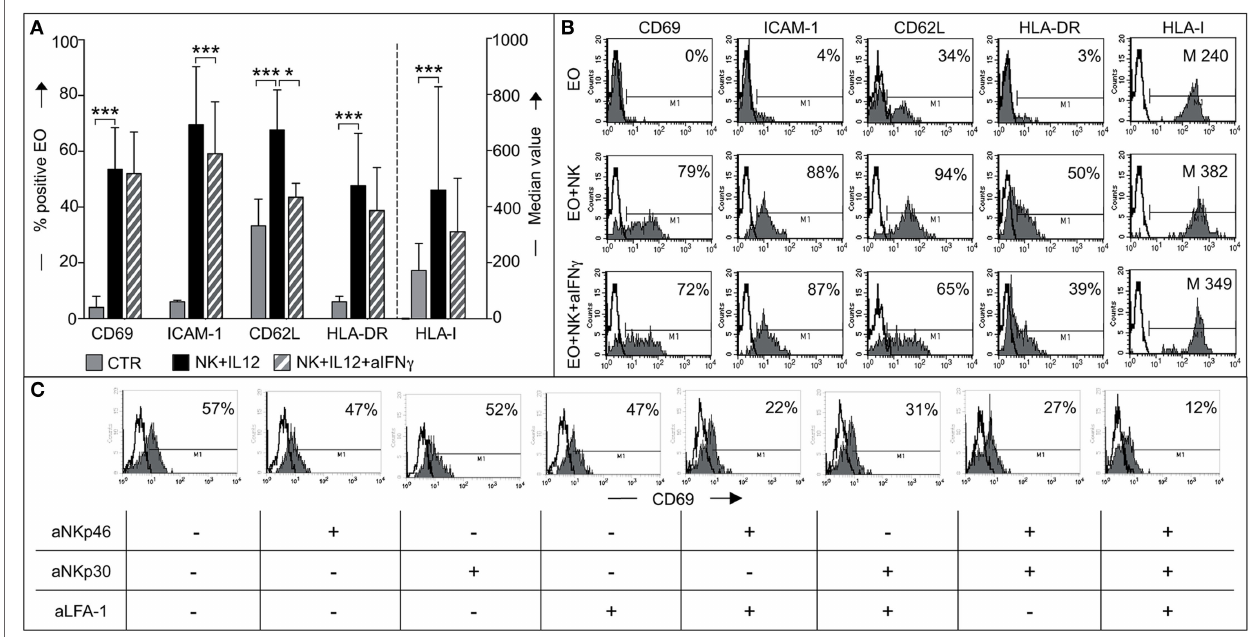
FigUre 6 | analysis of eosinophil (eO) activation induced by il12-conditioned nK cells . (a) EOs were cultured alone (CTR) or with IL12-conditioned NK cells at an E : T ratio of 1:1 in the presence or in the absence of neutralizing anti-IFN γ mAbs. After o.n. culture, EOs were harvested and assessed by flow cytometric analysis for maturation markers such as CD69, ICAM-1, CD62L, HLA-DR, and HLA-I. Surface expression of these markers on EOs was analyzed by gating on Annexin V − /ToPro3 − cells. The percentage of viable EOs (Annexin V − /ToPro3 − ) was 30–55% in CTR, 70–85% in cocultures containing NK + IL12 and 60–71% in those containing NK + IL12 + anti-IFN γ . The bars indicate the percentage of positive cells and the median value of HLA-I + EOs. Gray bars refer to EOs cultured alone, black bars represent EOs cocultured with NK + IL12 cells and striped bars refer to EOs cocultured with NK + IL12 cells in the presence of neutralizing anti-IFN γ mAb. The average of six independent experiments is shown (% ± SD). * P < 0.05; *** P < 0.001. (B) Surface expression of the markers analyzed in panel (a) is shown for one representative donor out of 6 analyzed. Open profile indicates staining with PE-conjugated anti-mouse IgG secondary reagent. The percentage of CD69, ICAM-1, CD62L, HLA-DR, and the median value of HLA-I are indicated. (c) EOs cells were cultured with IL12-conditioned NK cells at an E : T ratio of 1:1 in the presence ( + ) or in the absence ( − ) of the indicated blocking mAbs; after o.n. culture, EOs were harvested and assessed by flow cytometric analysis for CD69 expression by gating on AnnexinV − /ToPro3 − cells. Open profiles indicate staining with PE-conjugated anti-mouse IgG secondary reagent. The percentage of CD69 is shown for one representative donor out of six